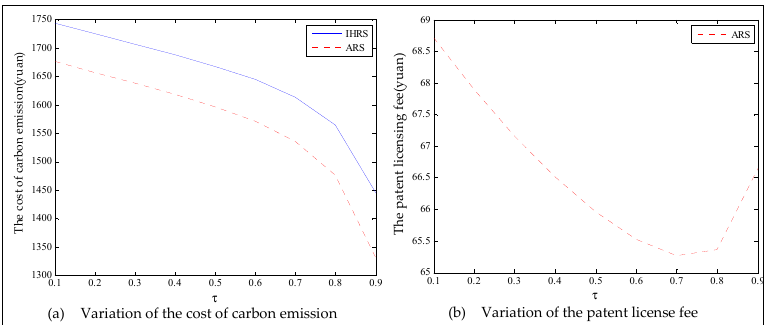
Figure 20. Changes in the costs of carbon emission and the patent licensing fee in Case 1 of Section 6.3.